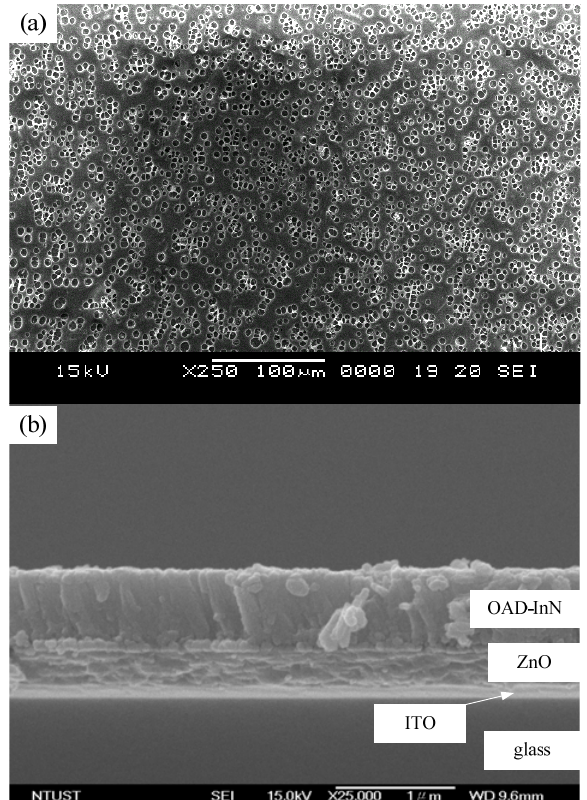
Figure 3. ( a ) Morphology of PbPc layer on glass substrate, and ( b ) cross-sectional FESEM image of OAD-InN/ZnO stack deposited on ITO